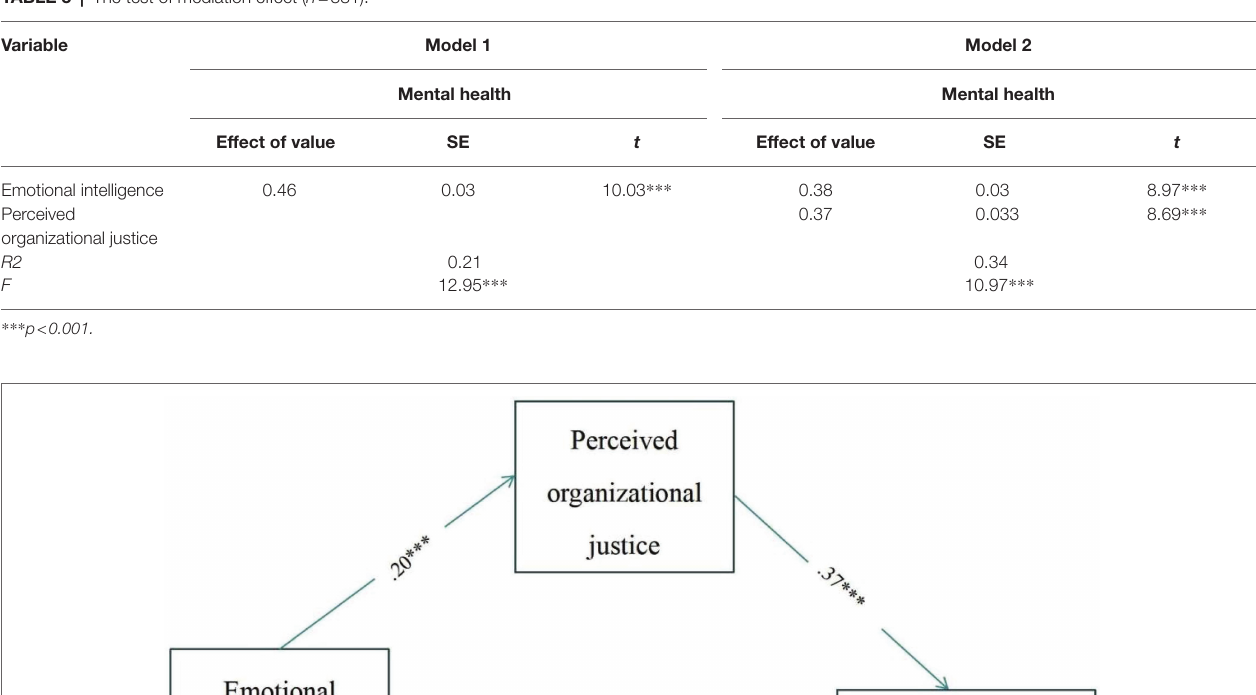
TABLE 3 | The test of mediation effect ( n =